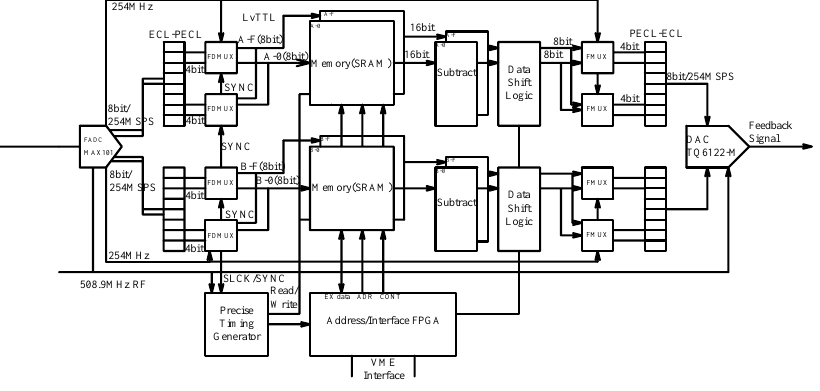
FIG. 5. Block diagram of the filter board.